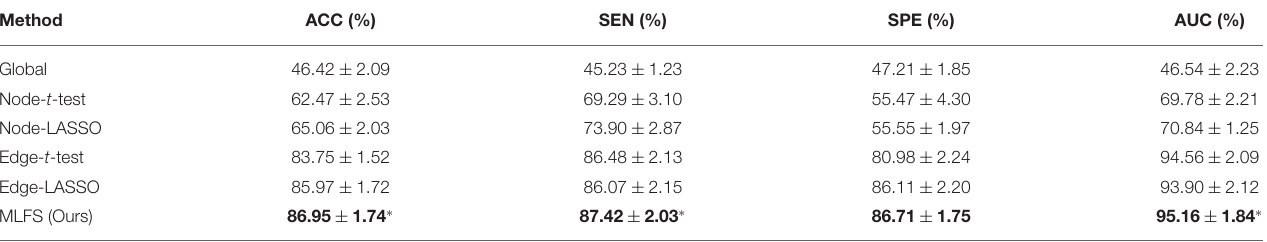
TABLE 3 | Classification performance of six schemes in MCI conversion prediction (i.e., lMCI vs. eMCI classification) using sparse inverse covariance to estimate the FBN (mean ± standard deviation). Method ACC (%) SEN (%) SPE (%) AUC (%)